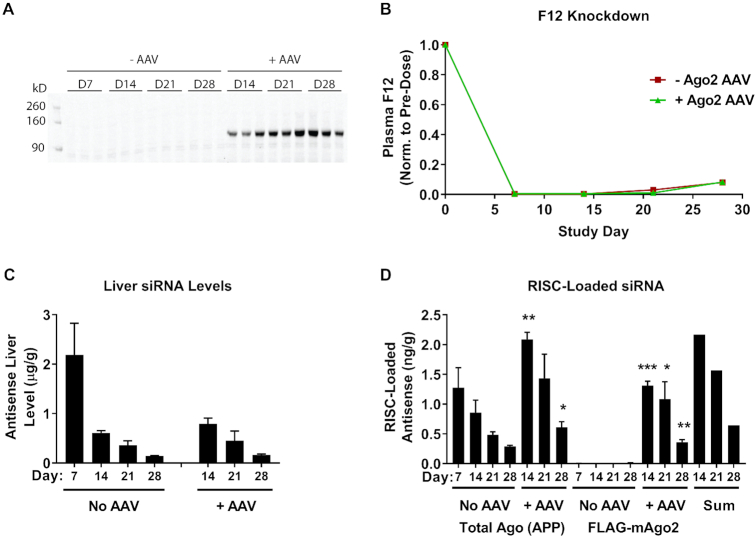
Exogenously expressed Ago2 loads F12 siRNA (siF12-1, 3 mg/kg) 1–3 weeks after dosing. An AAV vector was designed to express 3xFLAG-tagged mouse Ago2 (FLAG-mAgo2) under a constitutive liver-specific promoter (TBG). (A) Expression of the FLAG-mAgo2 protein was verified in AAV treated mice by Western Blot using an anti-FLAG antibody. Days refer to days post siRNA dose (day 0). FLAG-mAgo2 AAV was injected into three cohorts of mice on day 7 of the experiment (B) Plasma F12 protein levels were quantified by ELISA and normalized to pre-dose for each animal. (C) F12 antisense siRNA liver levels were quantified by RT-qPCR. (D) RISC loading was performed by anti-FLAG IP for both -AAV and +AAV groups (FLAG-mAgo2) and by Ago-APP for -AAV and +AAV groups (Total Ago (APP)). Loaded antisense siRNA was quantified by RT-qPCR. Data is represented as mean ± SD, for N = 3. Welch's independent t-test was utilized to compare the mean value between the control and +AAV groups at each timepoint in (C, D), with statistically significant increases in either liver level or RISC loading shown for the +AAV groups (*P ≤ 0.05, **P ≤ 0.01, ***P ≤ 0.001). Full results for the statistical analysis are included in the Supplemental Information.